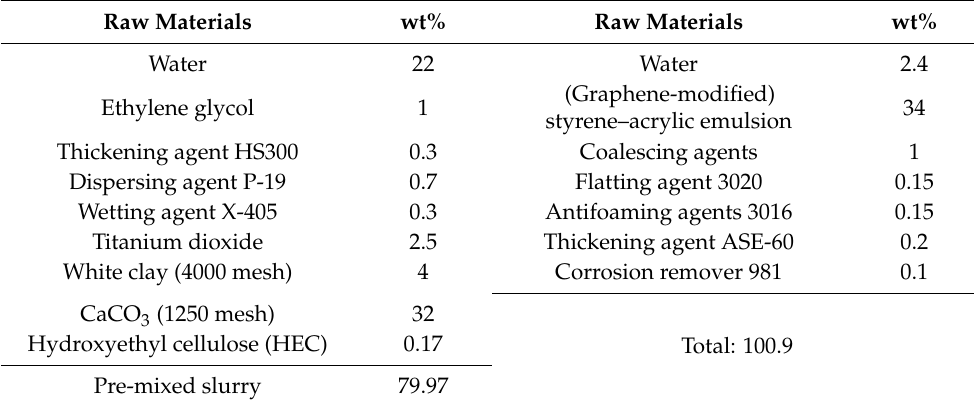
Table 1. Formulation of the graphene-modified styrene–acrylic architectural coating. Raw